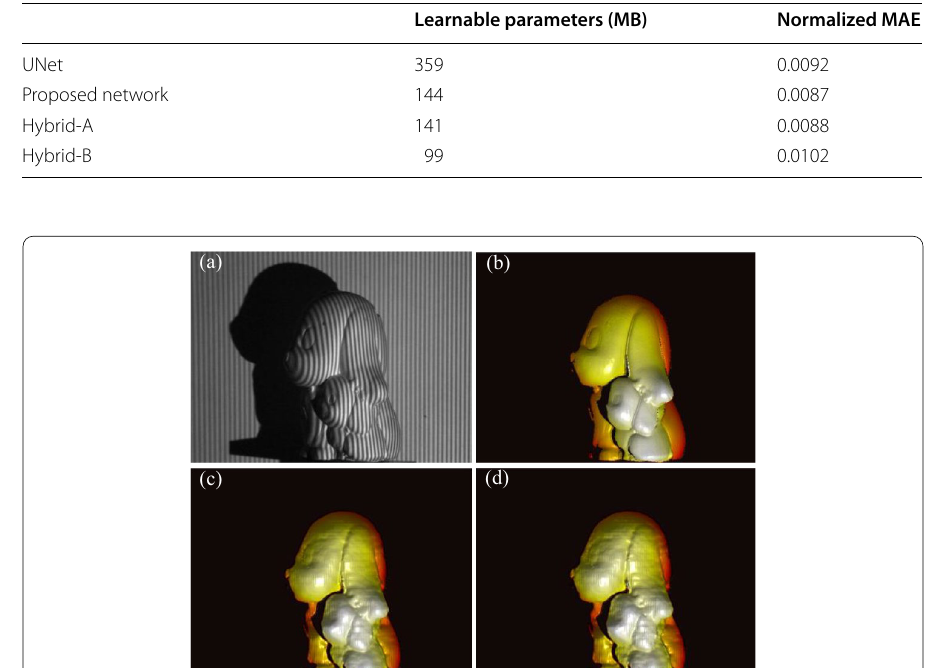
Fig. 6 The performance comparison of simplified dual-path hybrid networks: a the structured-light pattern; b ground truth; c result of Hybrid-A; d result of